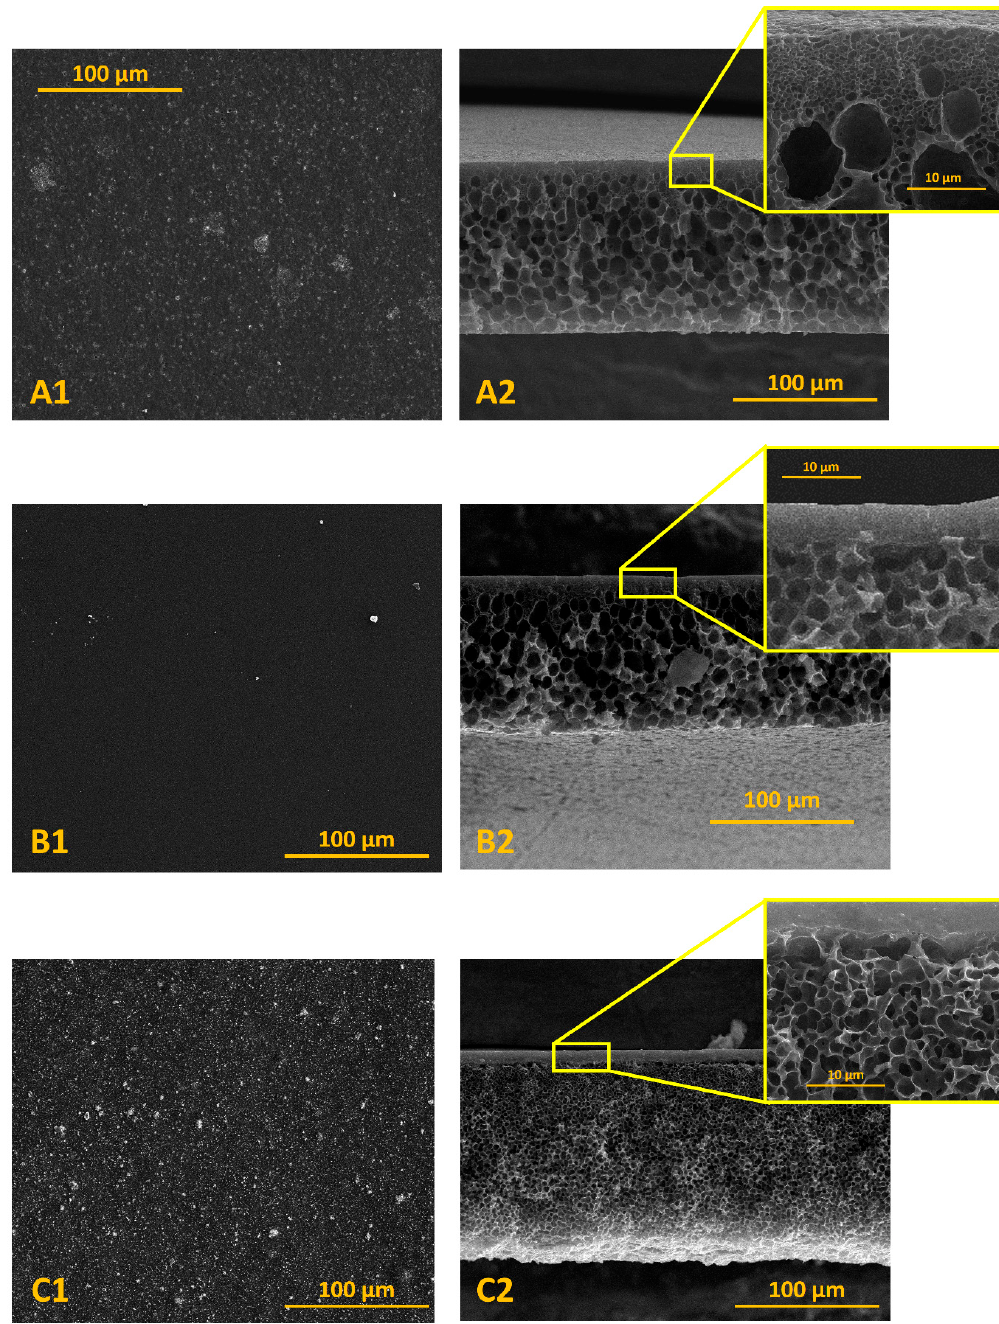
Figure 7. SEM micrographs of surface and cross-section of porous support PA6 ( A1 and A2 ), PVA/PA6 ( B1 and B2 ), and PVA-NaY/PA6 ( C1 and C2 ) composite membranes.